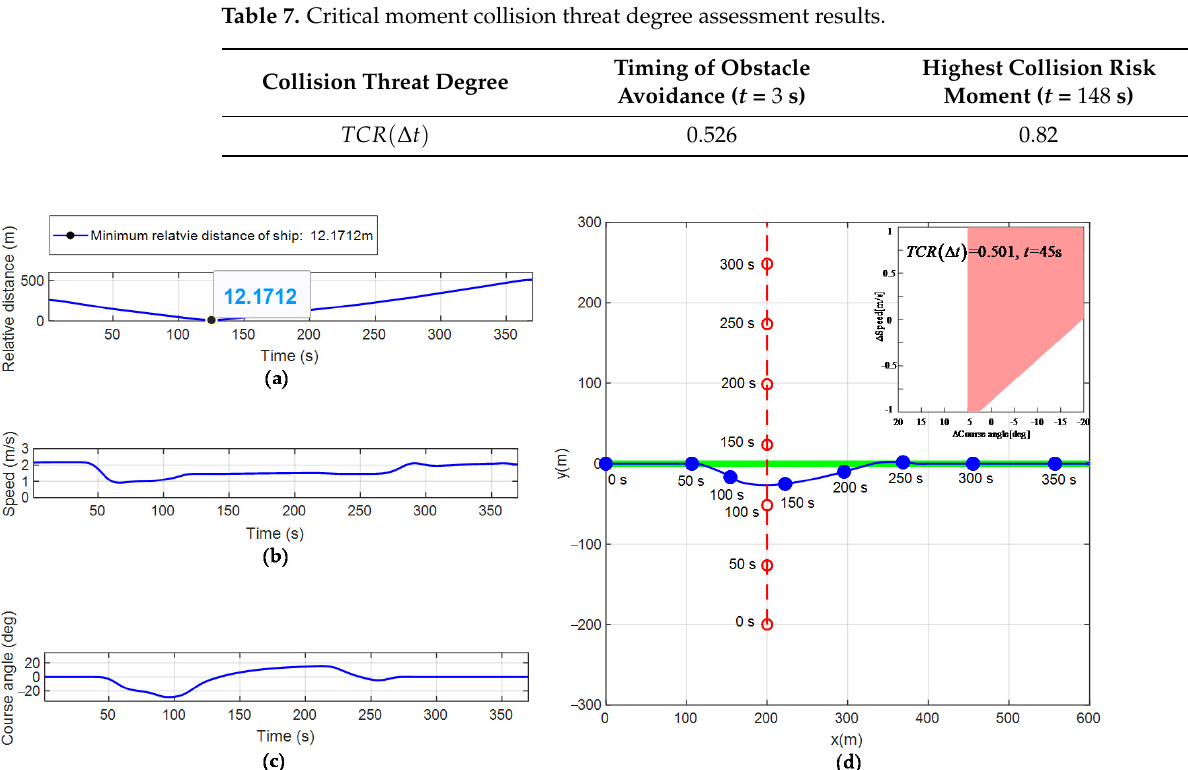
Figure 10. Obstacle avoidance process in the right cross encounter scenario. ( a ) Relative distance; ( b ) Change of velocity; ( c ) Change of yaw angle; ( d ) Obstacle avoidance process.